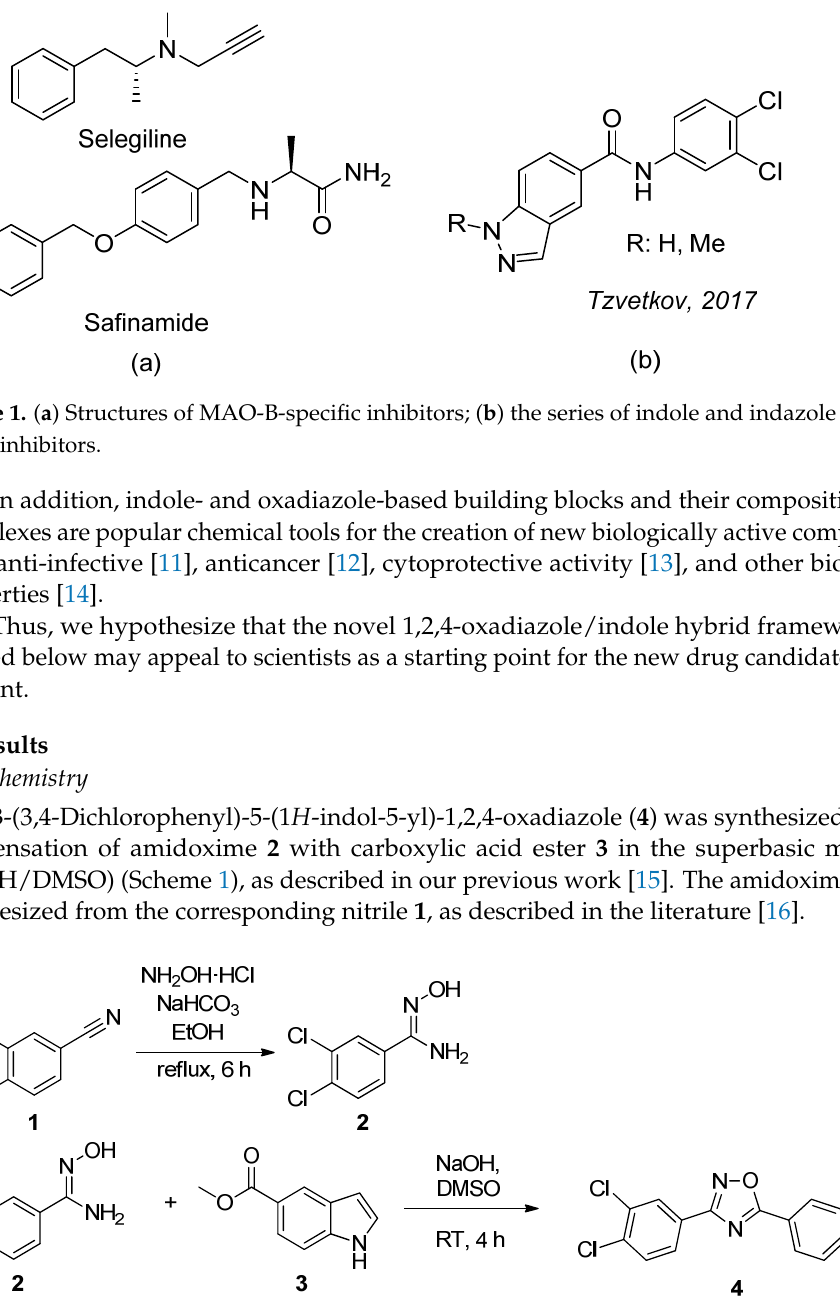
Figure 1. ( a ) Structures of MAO-B-specific inhibitors; ( b ) the series of indole and indazole derived MAO